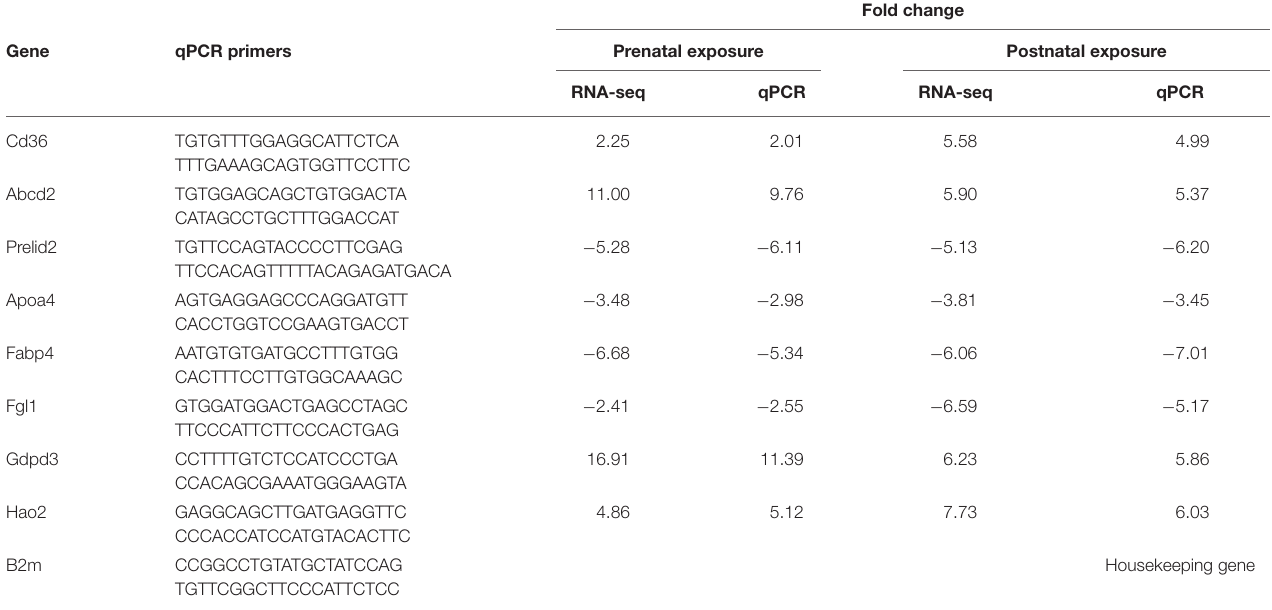
Fold change Gene qPCR primers Prenatal exposure Postnatal exposure RNA-seq qPCR RNA-seq